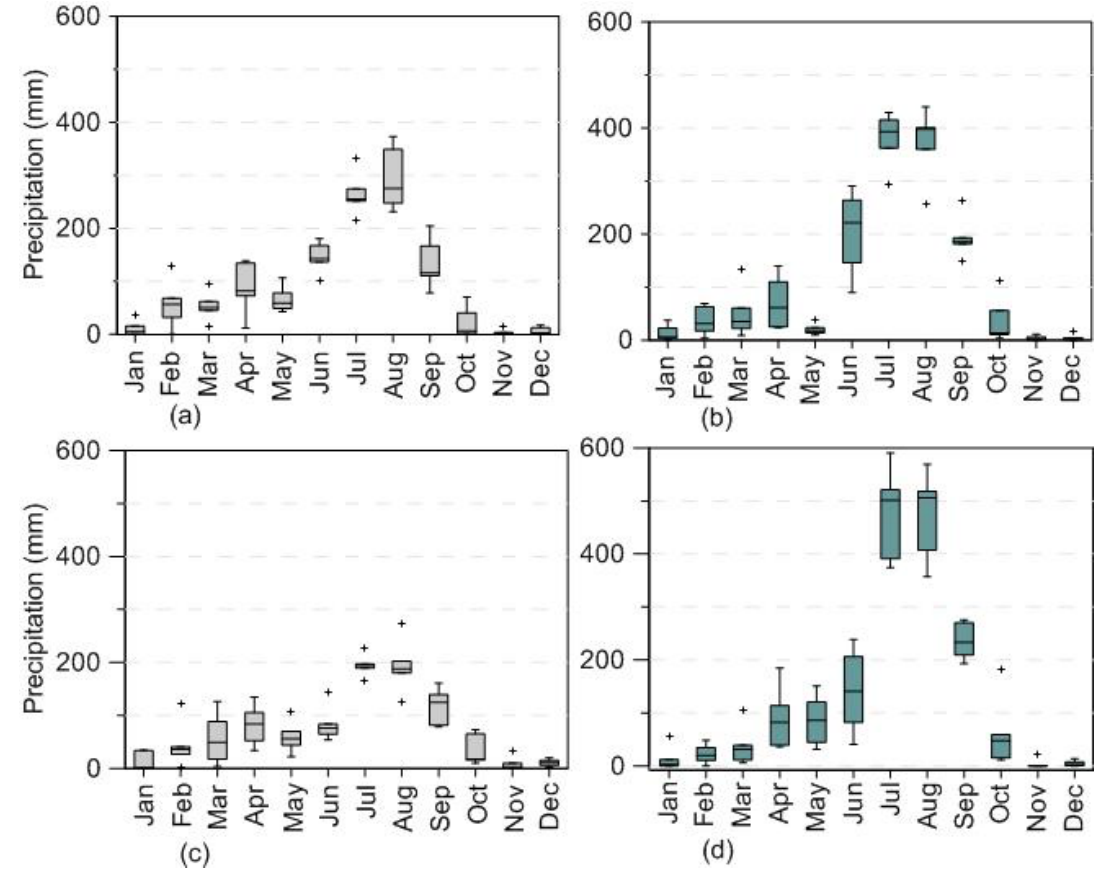
Figure 4. Average monthly areal rainfall distribution as box plots from the weather data (1990–2004). ( a ) Conventional meteorological weather station at Melka Kunture, ( b ) CFSR at Melka Kunture, ( c ) conventional at Keleta, and ( d ) CFSR at Keleta.